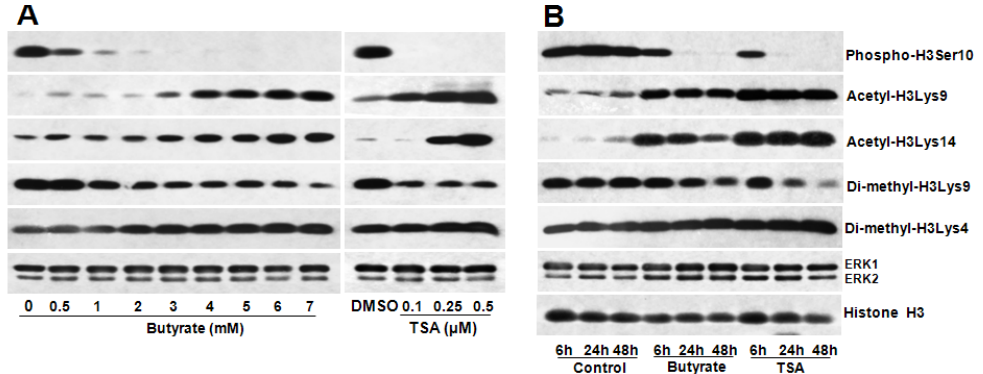
Figure 8. Concentration and time-dependent changes in site-specific modifications of histone H3 in butyrate and TSA treated VSMC. Proliferating VSMC were treated with different concentration of butyrate or TSA for 48 h ( A ) or treated with 5 mM butyrate or 0.5 µM TSA for indicated periods of time ( B ); to determine dose- and time-dependent effects of butyrate and TSA on indicated site-specific modifications of histone H3, respectively. At the conclusion of the treatment, VSMC were processed for western analysis using appropriate antibodies to assess the effects of butyrate and TSA on histone H3 modifications. ERK1/2 was immunoblotted and used as loading control. The results shown are representative of three independent experiments. The density of each band is measured and normalized to protein loading. The data obtained are analyzed and expressed as mean ± S.D. Phospho-H3Serine10, acetyl-H3Lys9, acetyl-H3Lys14, di-methyl-H3Lys9 and di-methyl-H3Lys4 modifications stimulated by butyrate vs. control are significant to very significant ( p < 0.01 to p < 0.001) depending on the concentrations of butyrate except for di-methyl-H3Lys4 modification, which is not significant at 0.5 and 1 mM butyrate concentration ( A ). Changes induced by TSA vs. DMSO are significant to very significant ( p < 0.01 to p < 0.001) with the exception of acetyl-H3Lys14 and di-methyl-H3Lys4 at 0.1 µM TSA ( A ). Time-dependent changes in levels of phospho-H3Serine10, acetyl-H3Lys9, acetyl-H3Lys14, di-methyl-H3Lys9 and di-methyl-H3Lys4 histone H3 modifications are significant to very significant ( p < 0.05 to p < 0.001) both in butyrate and TSA treated VSMC compared to untreated control at all periods of time with the exception of di-methyl-H3Lys9 at 6 h ( B ); ( C ) Effect of butyrate and TSA on acetylation of H3Lys9, and H3Lys14 was also determined by intracellular immunofluorescence staining of H3Lys9, and H3Lys14 followed by nuclear staining with Hoechst. VSMC treated with butyrate or TSA for 24 h were immunostained with respective antibodies and images of immunostained VSMC were captured using Nikon fluorescence microscope with a CCD camera (400×